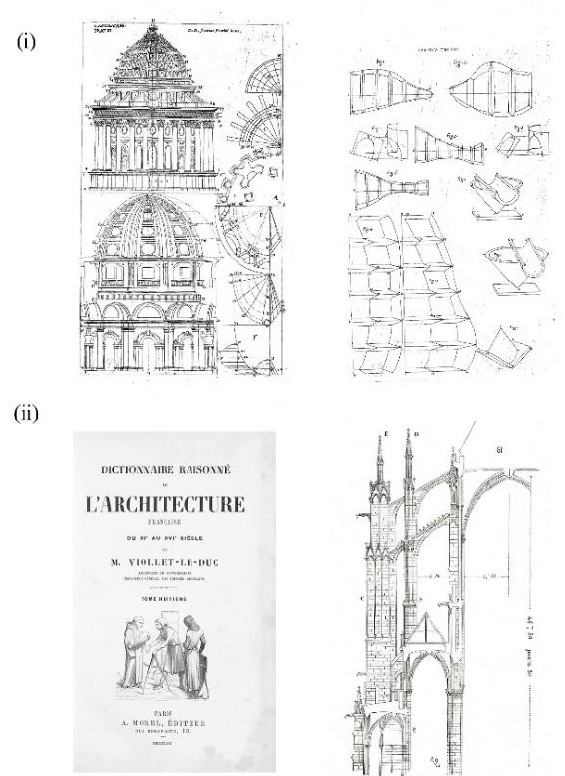
Figure 1. (i) ‘Architettura civile del padre D. Guarino Guarini: opera postuma’, 1737. ETH-Bibliothek Zürich, Rar (Public Domain Mark). (ii) Dictionnaire Raisonné de L'Architecture Française du XIe au XVIe siècle, Eugène Viollet-le-Duc, Édition Bance-Morel de 1854-1868. ‘Arc.boutant’, Beauvais